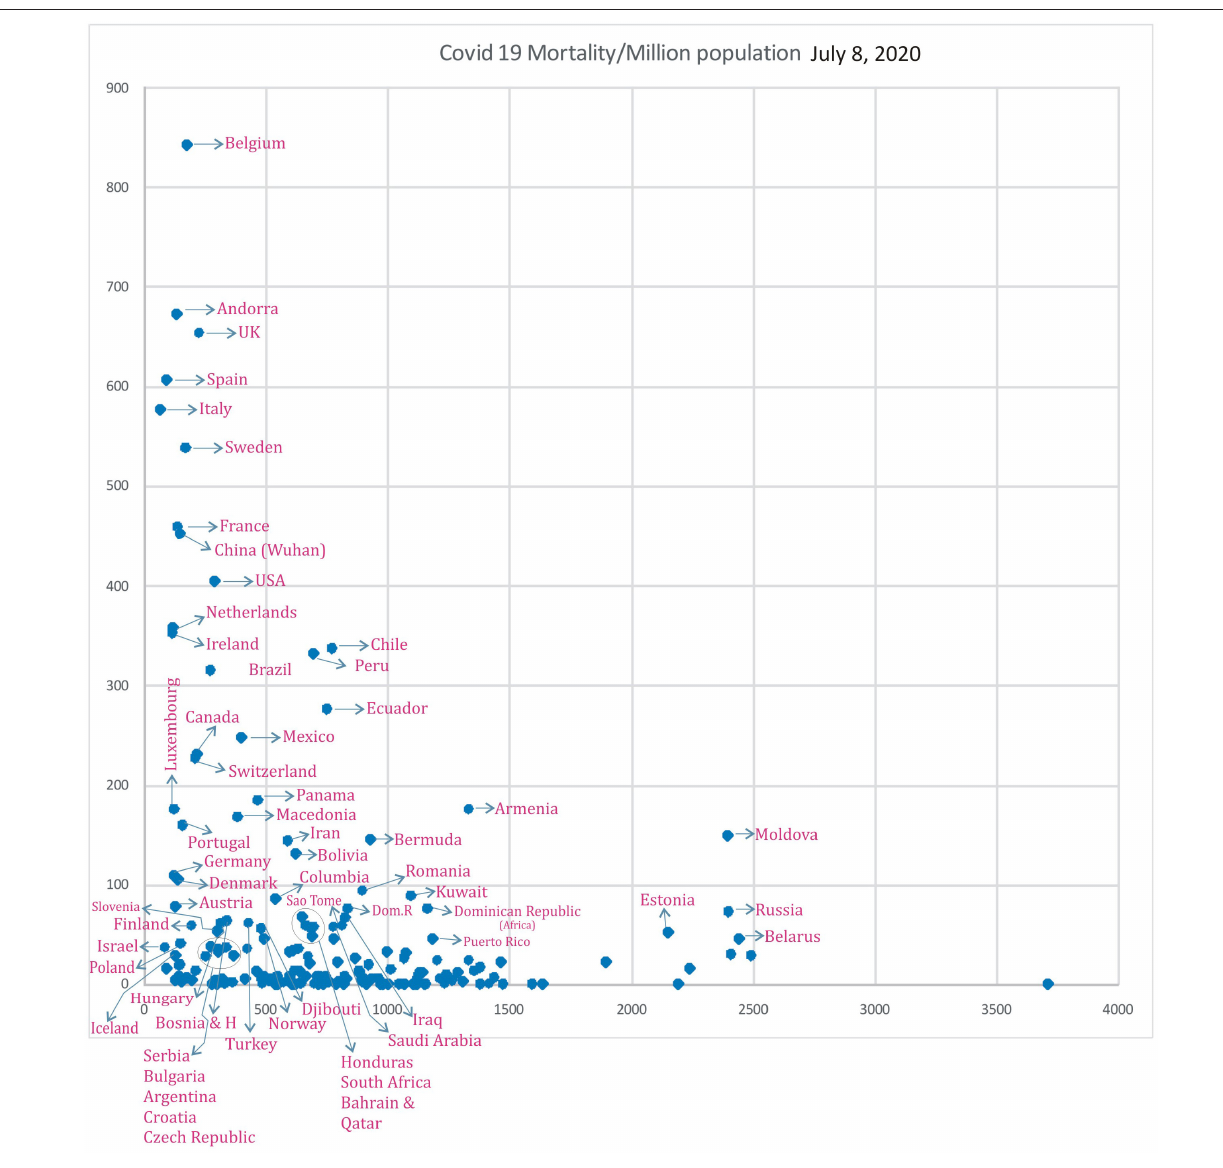
FIGURE 11 | Correlation of Influenza LRI’s/100,000 (x) vs. COVID-19 Mortality in various countries (y) (July 8, 2020 n =